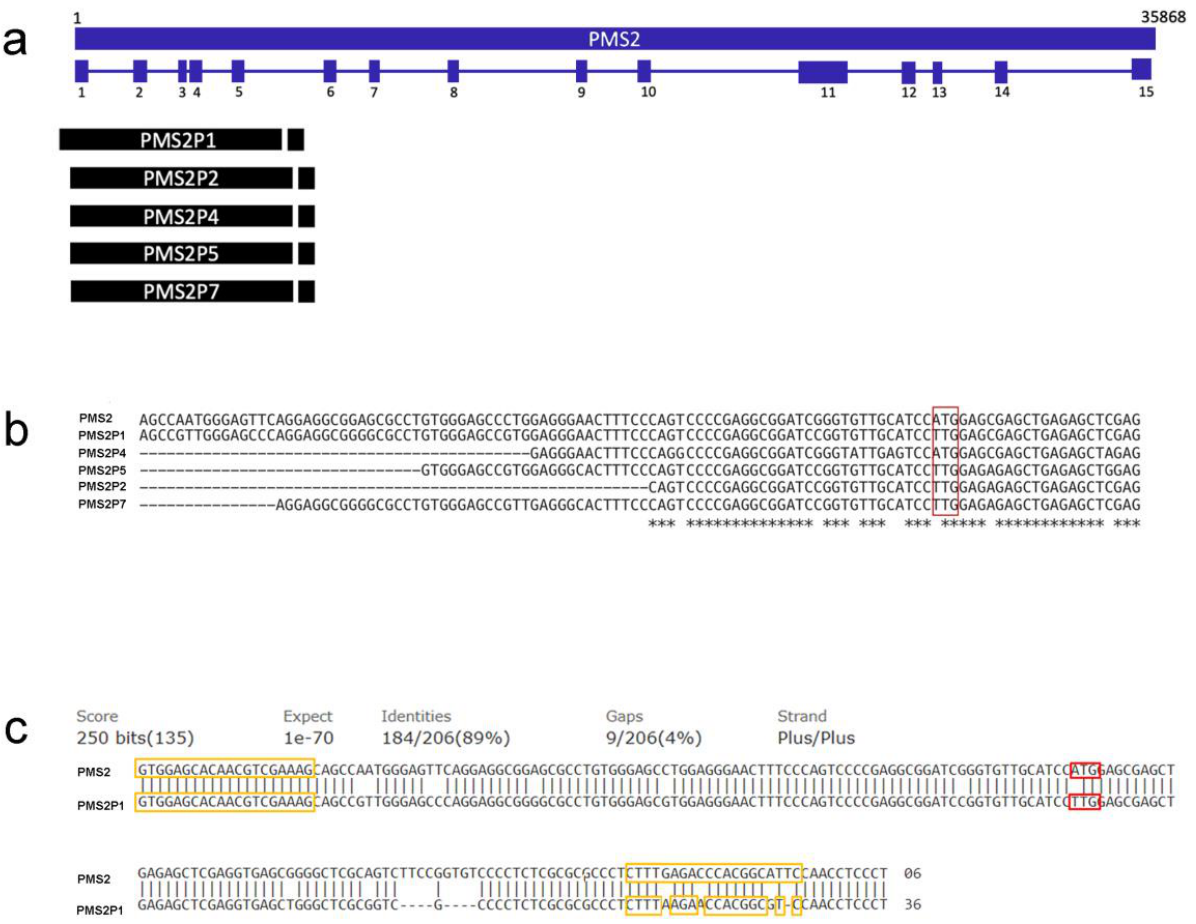
Figure 3. A schematic diagram of the genomic structure of PMS2 and the pseudogenes. ( a ) The blue boxes show the 15 exons of the PMS2 gene, whose position is representative. The black boxes show the pseudogenes that match exon 1 and exon 5. ( b ) Multiple sequence alignment of exon 1; red box denotes c.1A > T, (p.Met1Leu) in PMS2 ; asterisk (*) denotes conserved nucleotide in all sequences. ( c ) Alignment of the PCR amplicon with the reference sequence of the pseudogene PMS2P1 . The yellow boxes indicate the complementarity of the forward and reverse primers. The red box indicates the site of change c.1A > T, (p. Met1Leu).